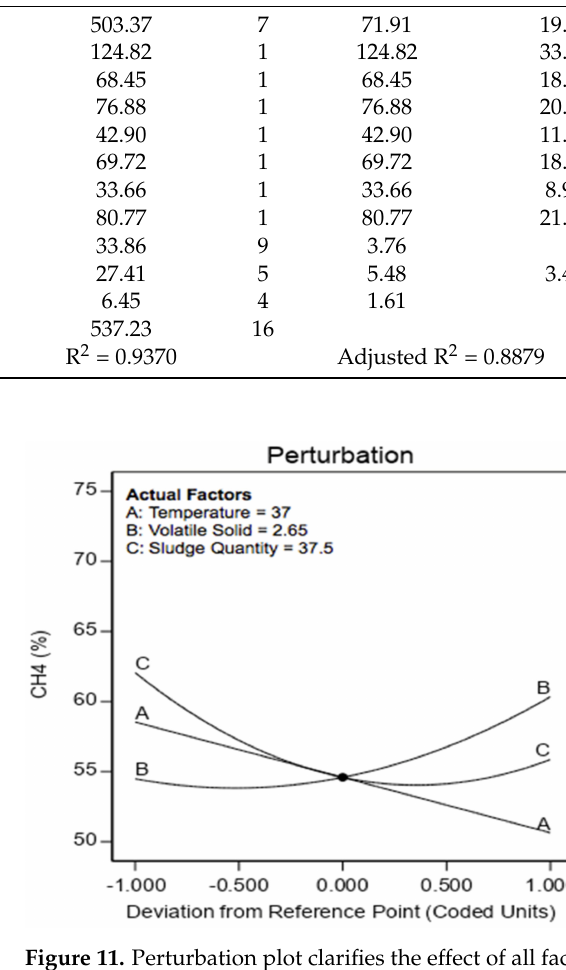
Figure 11. Perturbation plot clarifies the effect of all factors on CH 4